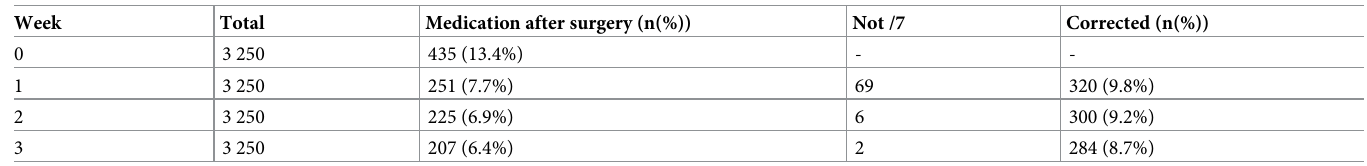
Table 4. Adjusted and unadjusted percentages for incorrect linkage medication after death.